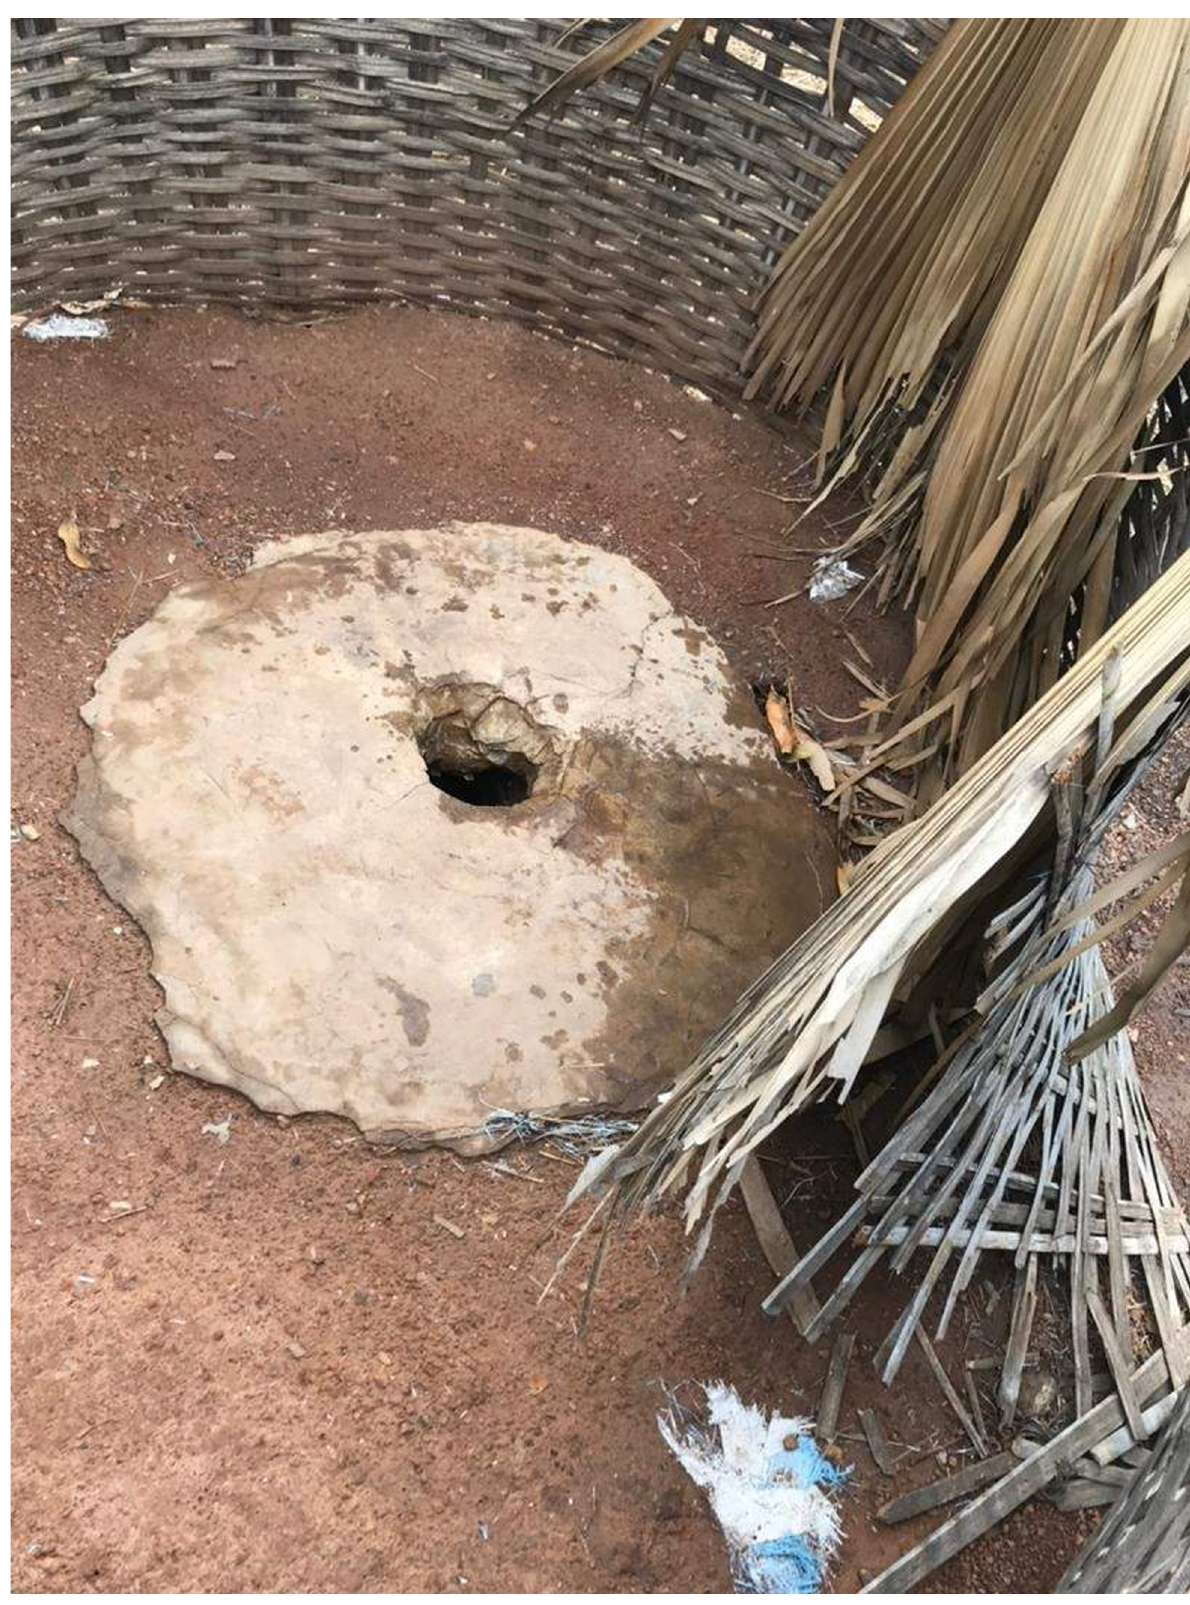
Fig 5. Picture of a toilet facility in Saraya site.